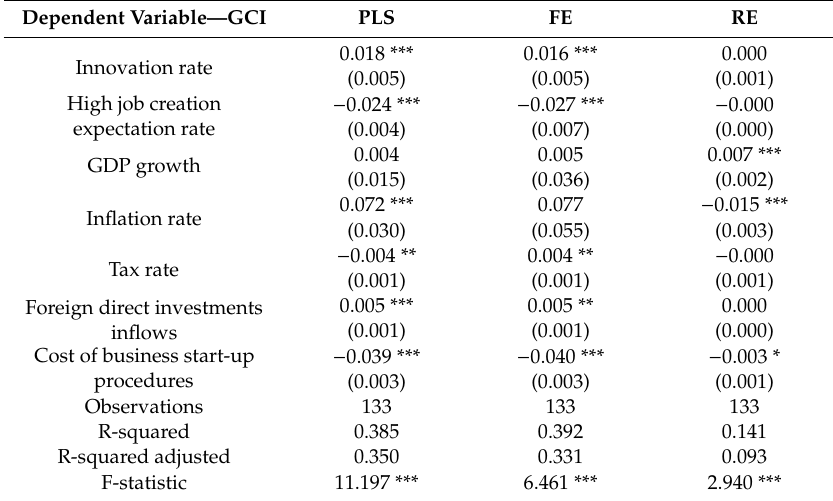
Table 5. E ff ects of entrepreneurship performance on